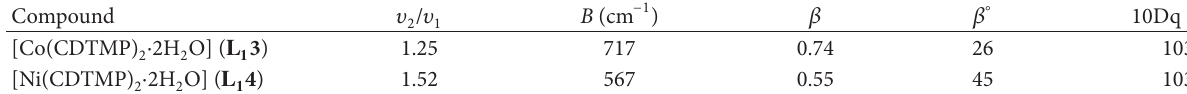
T 5: Electronic parameters of Ni(II) and Co(II) complexes.